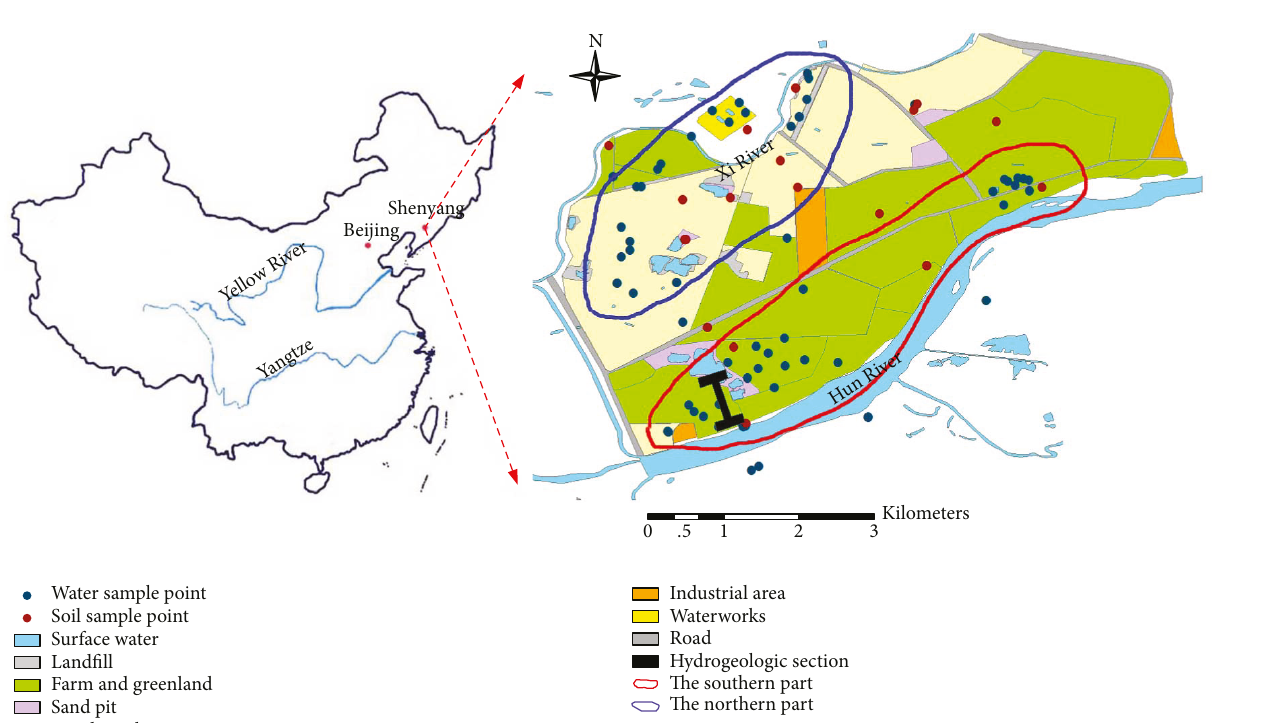
Figure 1: Location map of the study area. Modi fi ed from L. Y. Liu et al.